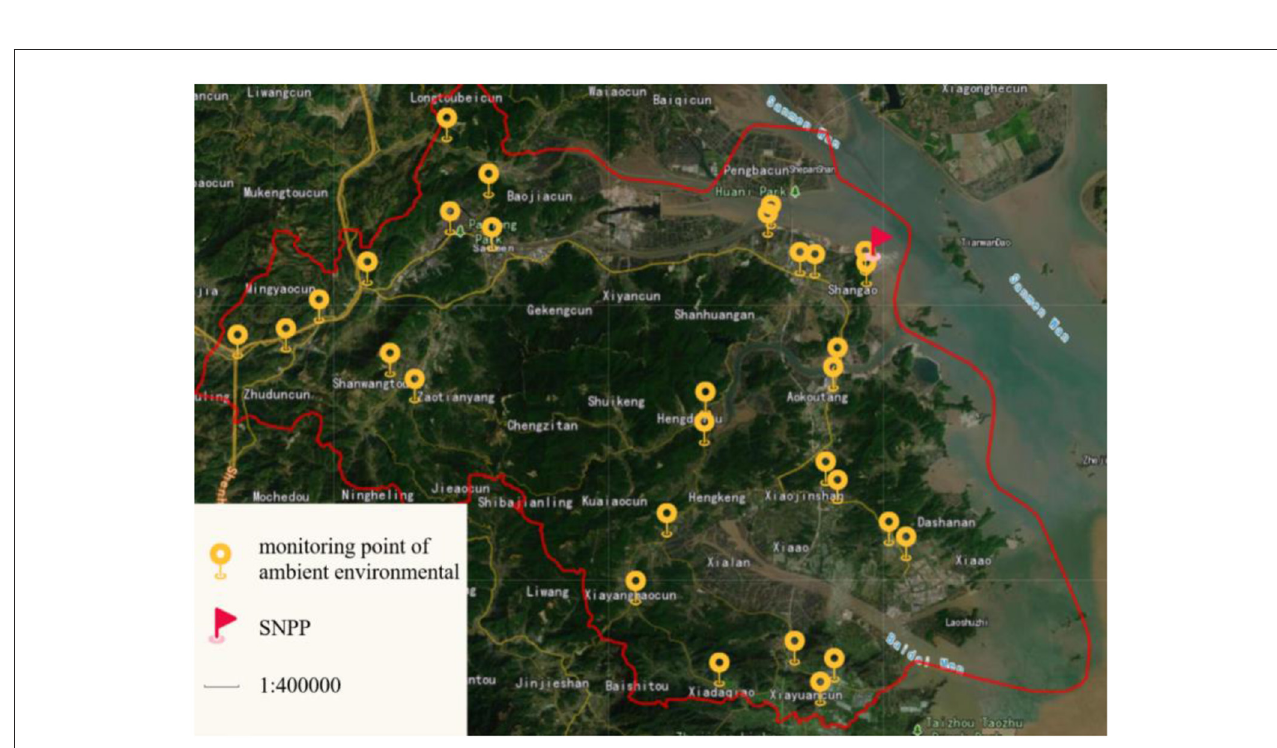
FIGURE2 Monitoring stations for ambient radiation exposure of ambient environmental around